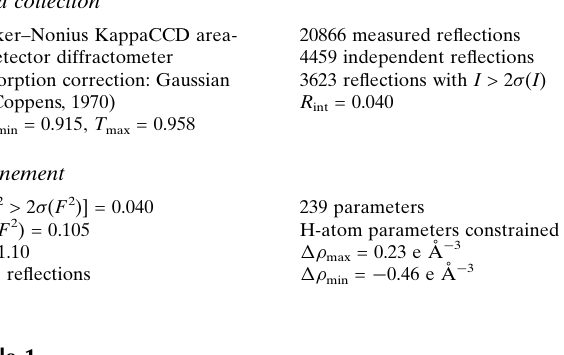
Hydrogen-bond geometry (A˚ , (cid:4)